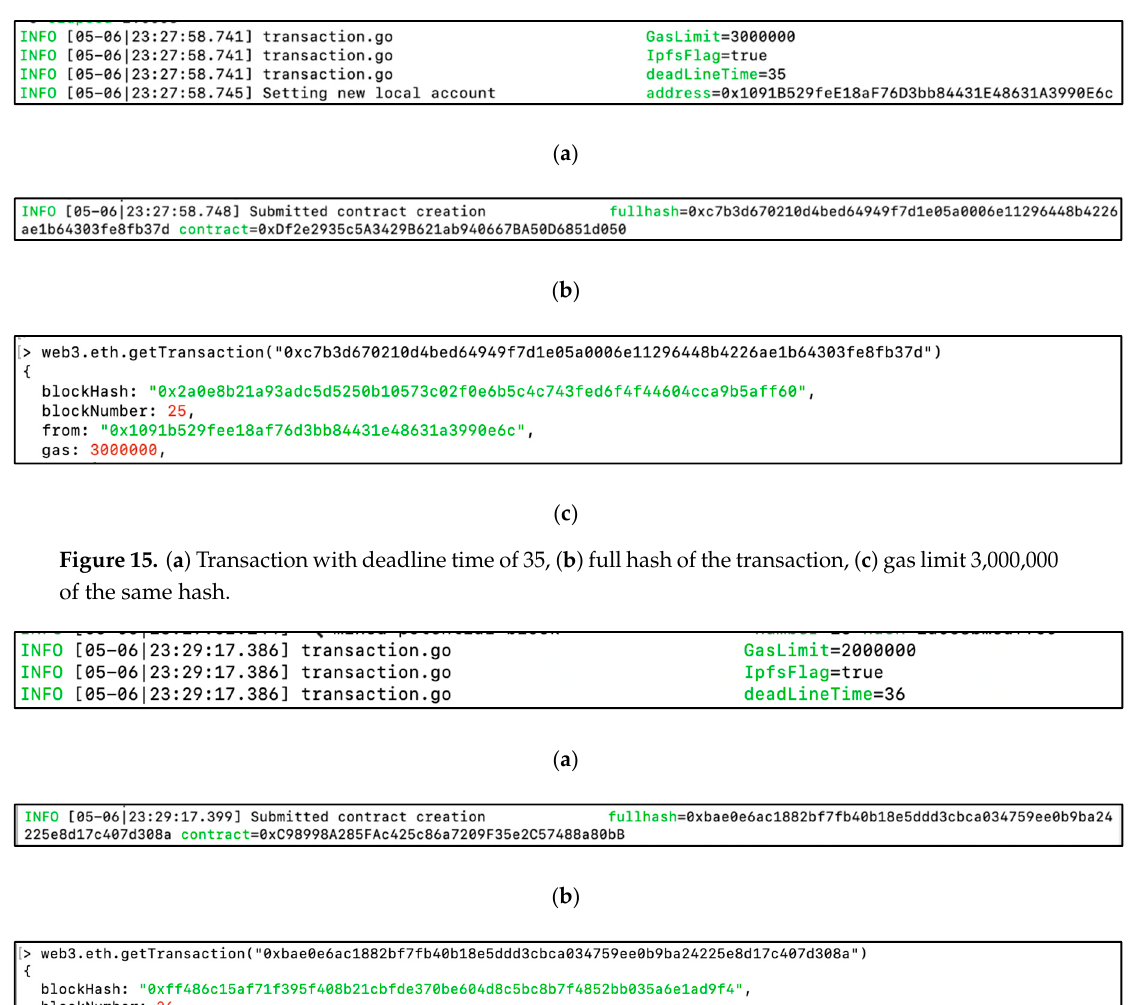
Figure 16. ( a ) Transaction with deadline time of 36, ( b ) full hash of the transaction, ( c ) gas limit 2,000,000 of the same hash.